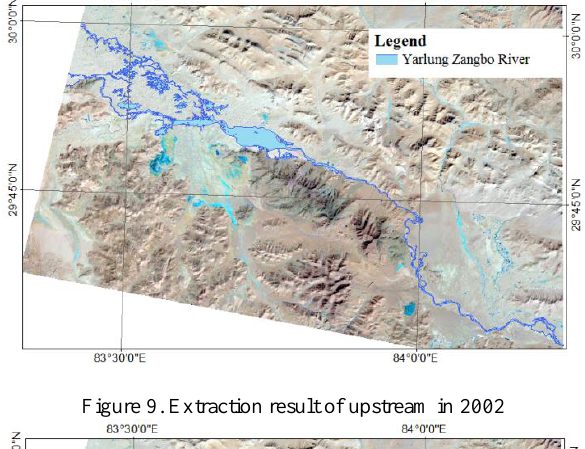
Figure 9. Extraction result of upstream in 2002